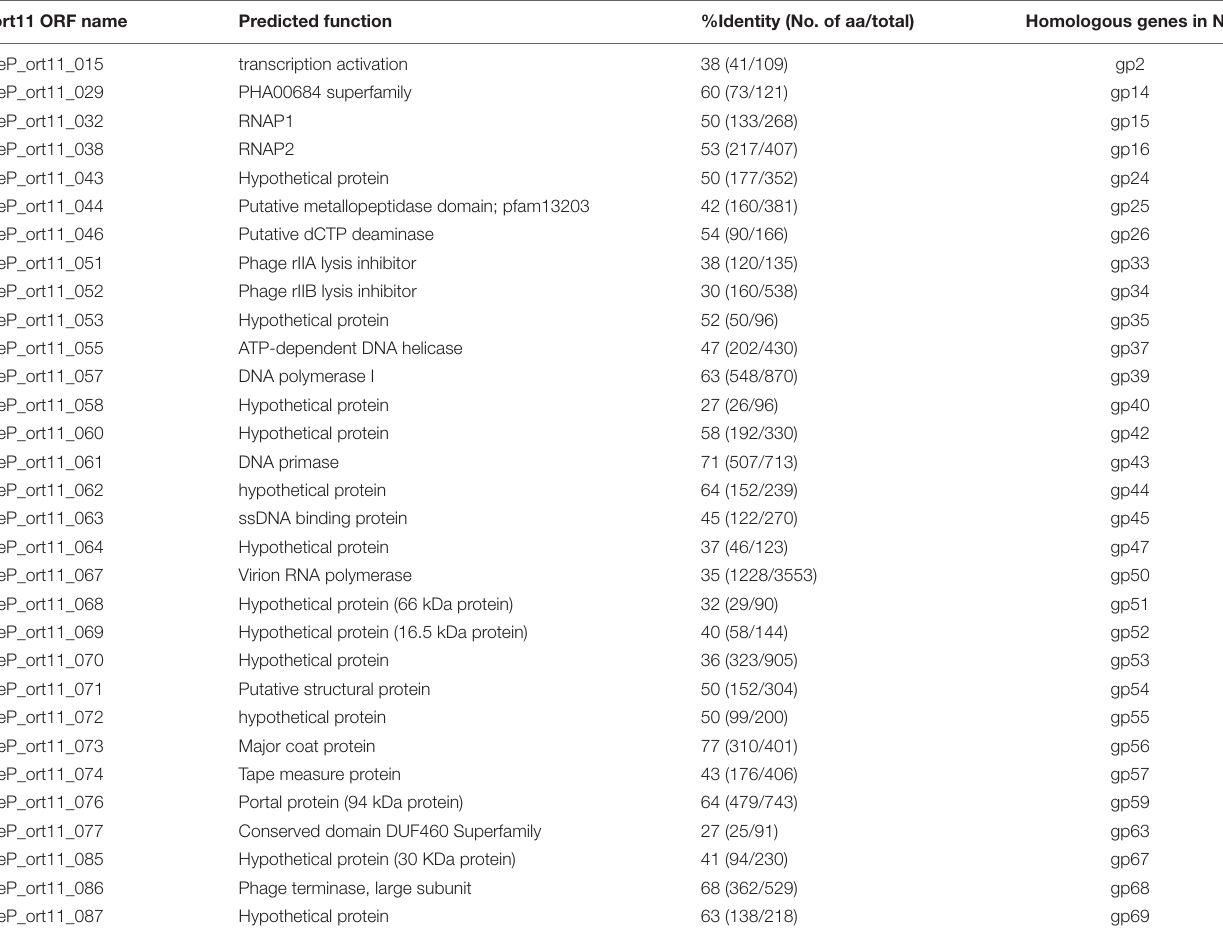
FIGURE 4 | Genome map of P_ort11 and comparison with Escherichia phage N4. Proposal functional clusters are marked by the same color. Shading indicates the degree of amino acids sequence identity of gene products with an identity of > 20%. Putative functions of genes are indicated. TABLE 3 | Comparison of Sinorhizobium phage P_ort11 predicted proteins and their orthologs in Escherichia phage